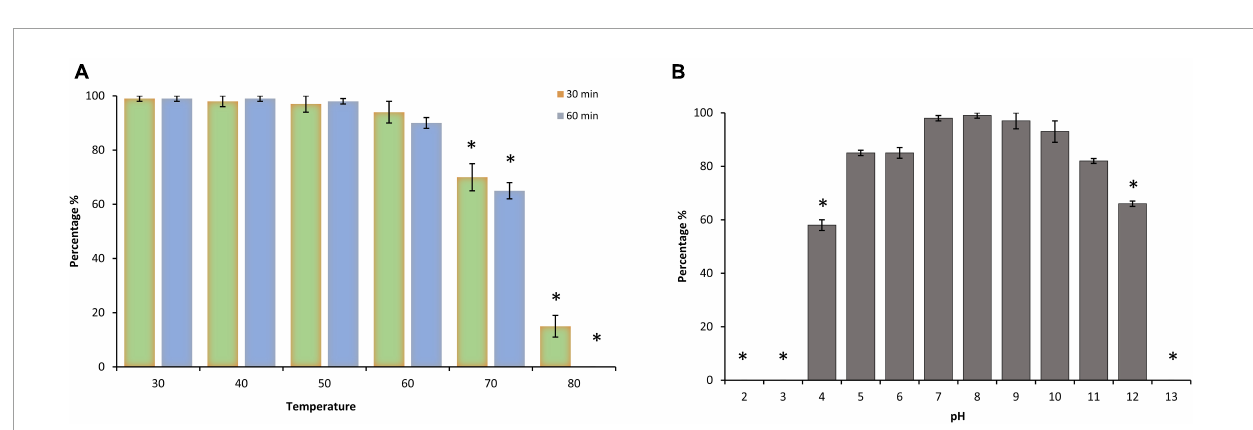
FIGURE3 Thermal and pH stability test of phage LPSent1. (A) Thermal stability of LPSent1. (B) pH stability of LPSent1. Temperature stability tests were performed at 40, 50, 60, 70, and 80 ◦ C for 30 min or 60 min at pH 7, the control temperature was set at 30 ◦ C for 30 min or 60 min. pH experiments were performed at pH range 2-13 for 24 h at 37 ◦ C, pH 7 represented the control value around which the deviations were measured. The data ( n = 3) displayed the percentages of the residual phages after each treatment, as normalized from the control ± standard error and were analyzed by Student’s t -test; ∗ indicates significantly different from the controls, p ≤